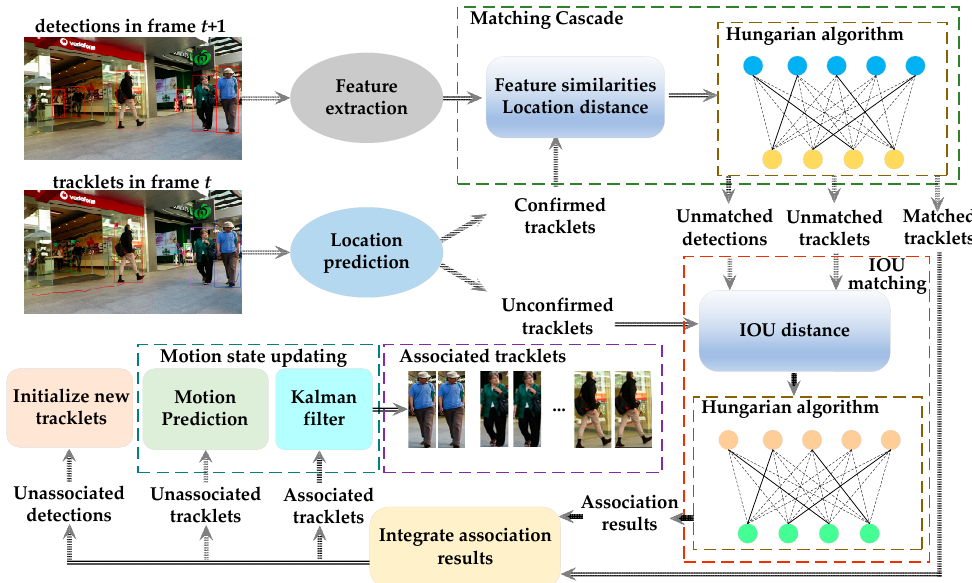
Figure 3. The overall framework of SORT-YM.